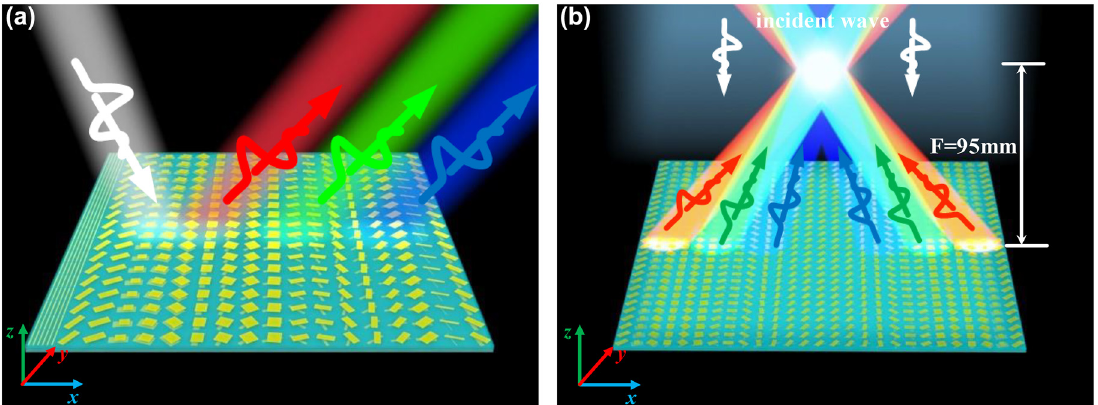
Figure 1: Schematic of the broadband achromatic meta-devices. (a) Beam deflection and (b) achromatic EM waves focusing with the focal length of 95 mm. The RCP plane waves are incident normally on the metasurface and the achromatic performance can be observed at reflective